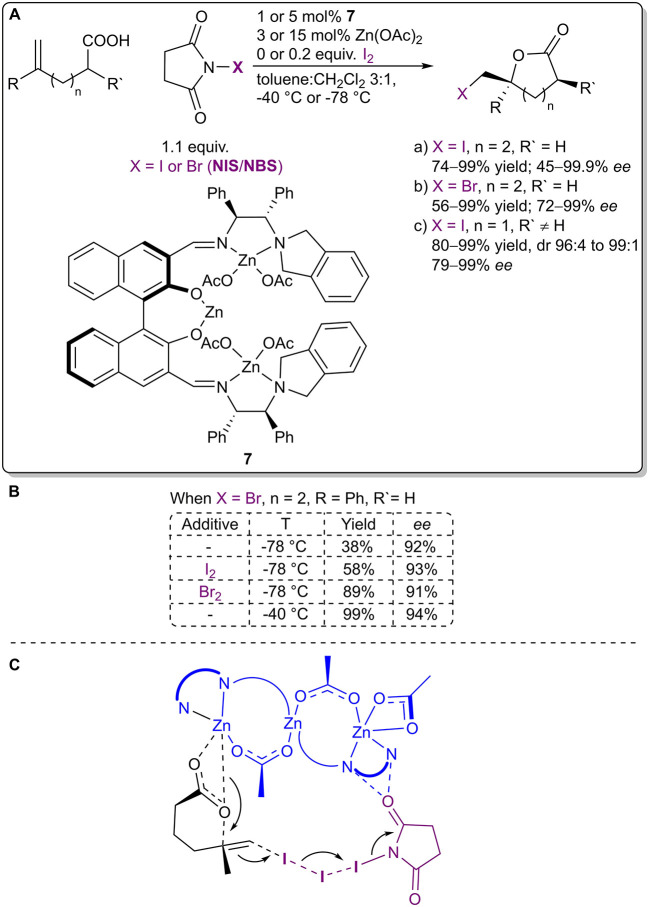
(A) Zinc acetate-catalyzed asymmetric halolactonization using the I2-NIS/NBS complex as a halogenating agent; (B) the influence of additives and temperature on the bromolactonization; (C) the proposed transition state for the iodolactonization.